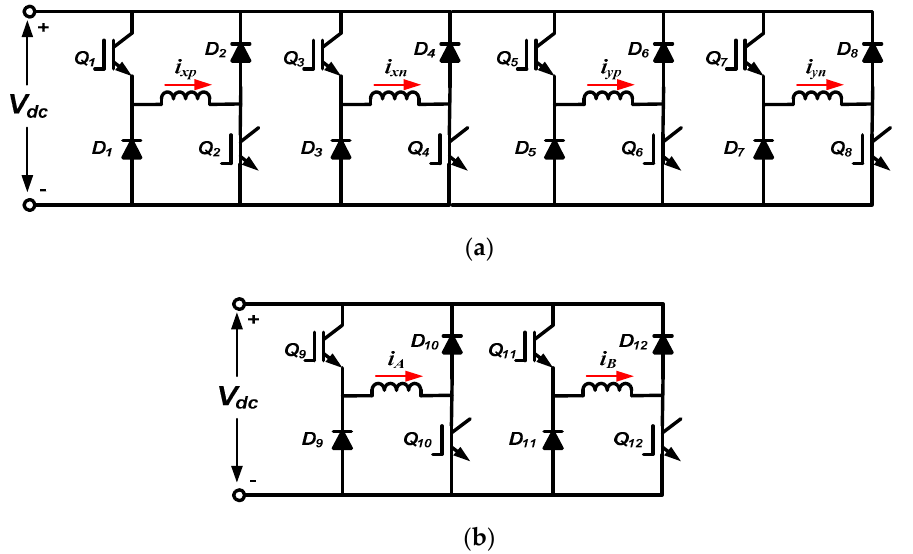
Figure A1. ( a ) Asymmetric converter for torque windings. ( b ) Asymmetric converter for suspending force windings.